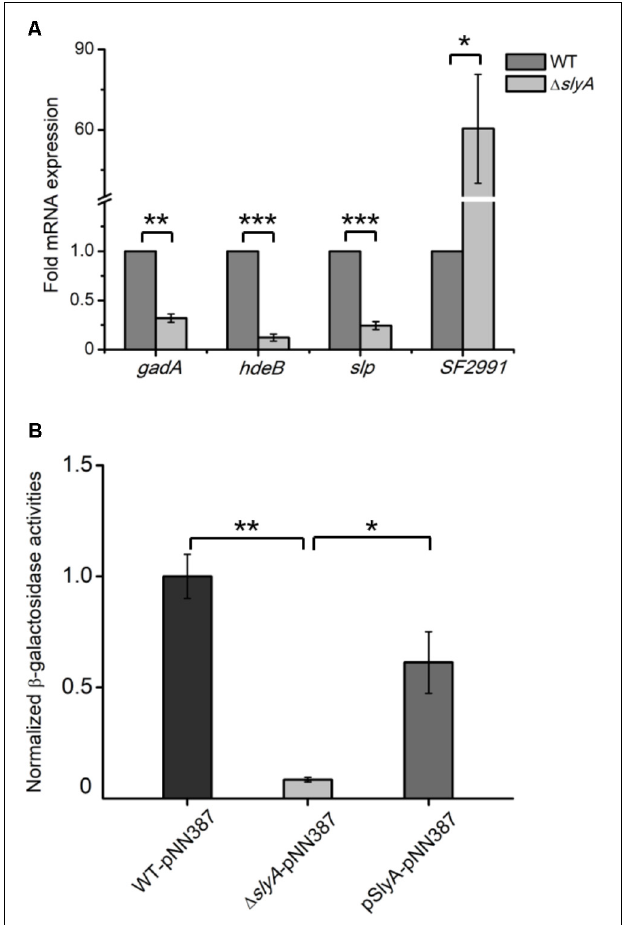
FIGURE 2 | SlyA activates the expression of gadA at the transcriptional level. (A) qRT-PCR analyses of mRNA samples extracted from Shigella WT and (cid:49) slyA strains. (B) Measurements of β -galactosidase activities in WT, (cid:49) slyA , and (cid:49) slyA +pSlyA strains harboring a plasmid encoding a promoterless lacZ fused with the gadA promoter. β -Galactosidase activities from three biological replicates are shown with values normalized to that of the WT strain. Asterisks indicate significant differences ( ∗ p < 0.05, ∗∗ p < 0.01, and ∗∗∗ p < 0.001).